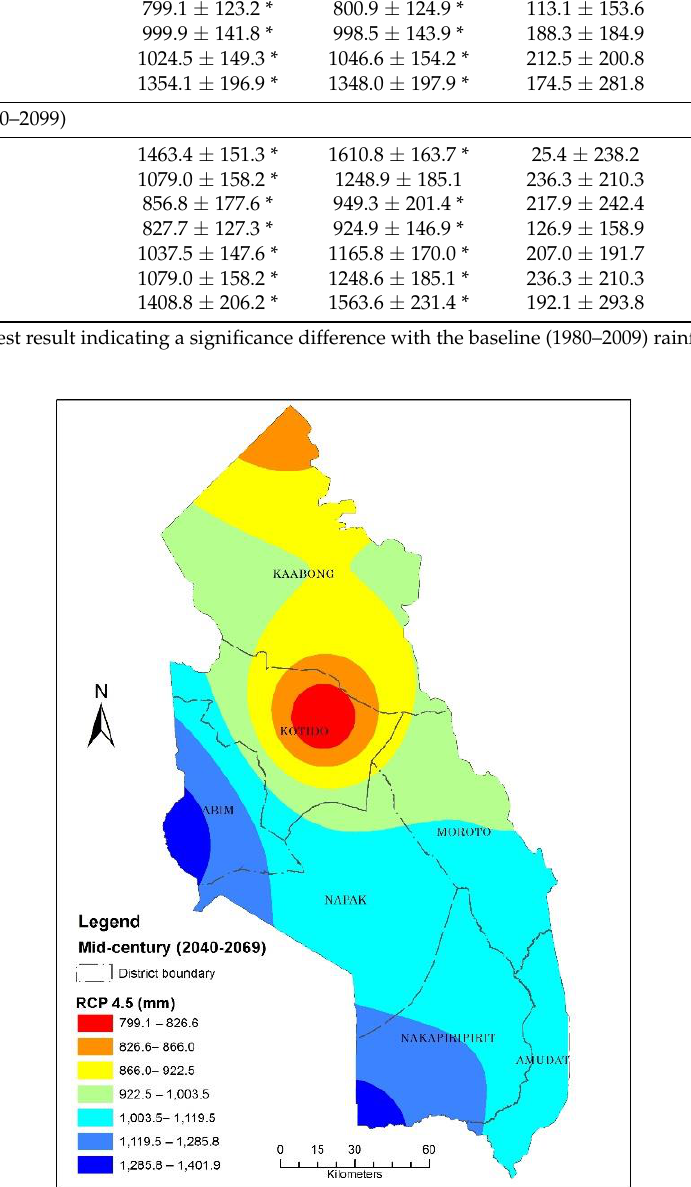
Table 4. Projected rainfall in Karamoja sub-region.